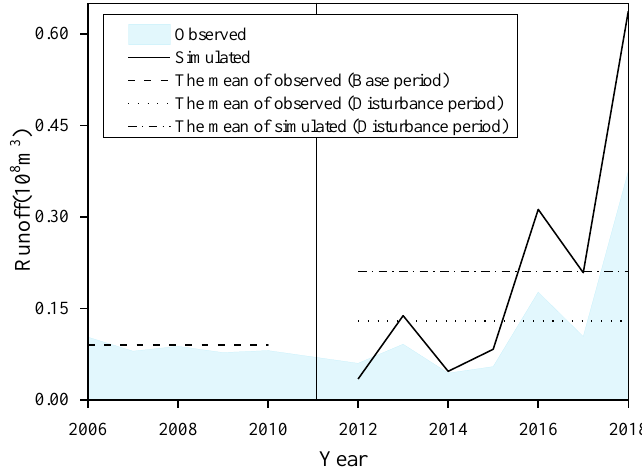
Figure 9. Runoff impact assessment model results in the Guishui River Basin.